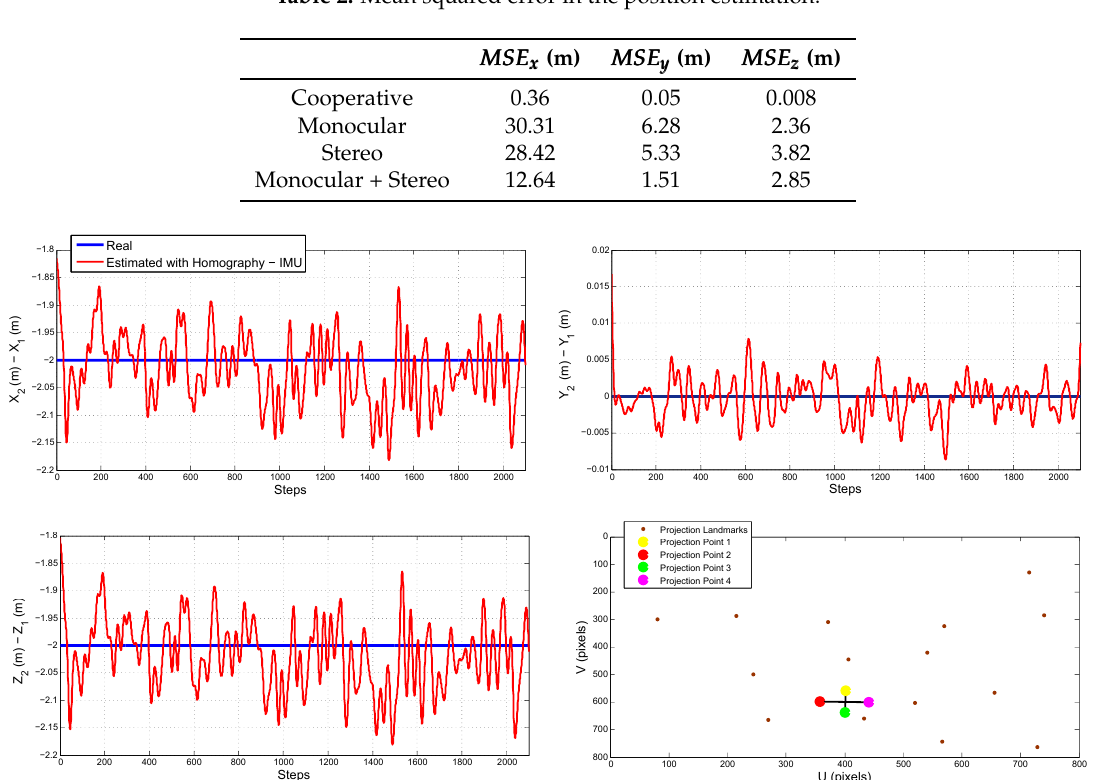
Figure 10. Estimation of the relative distances between the flying vehicles by means of